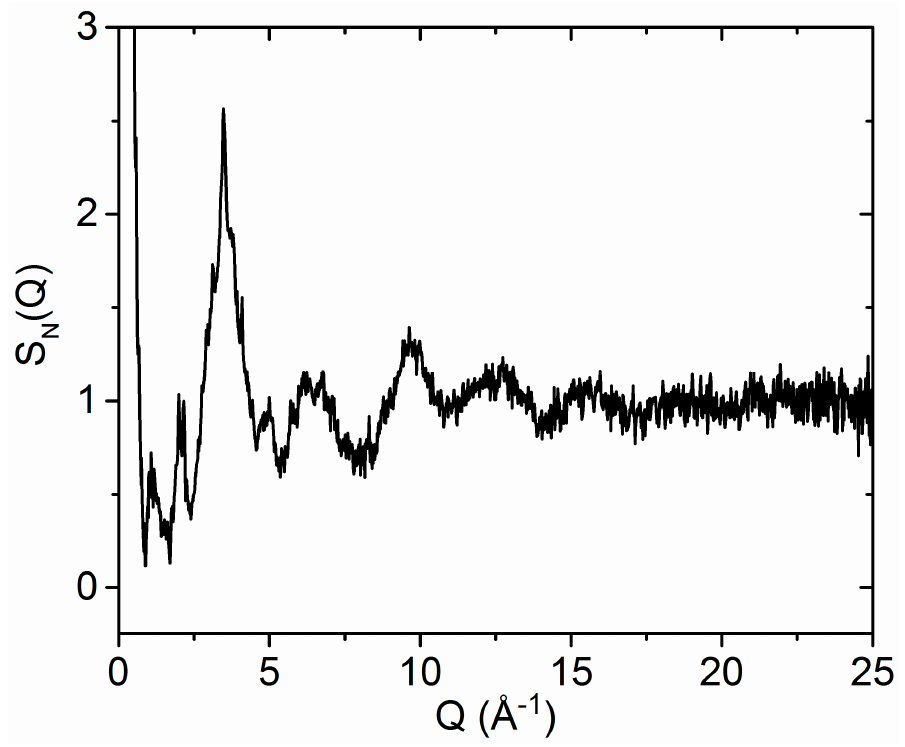
Figure 2. The neutron diffraction structure factor S N (Q) measured from the 2010 amorphous hafnia sample.